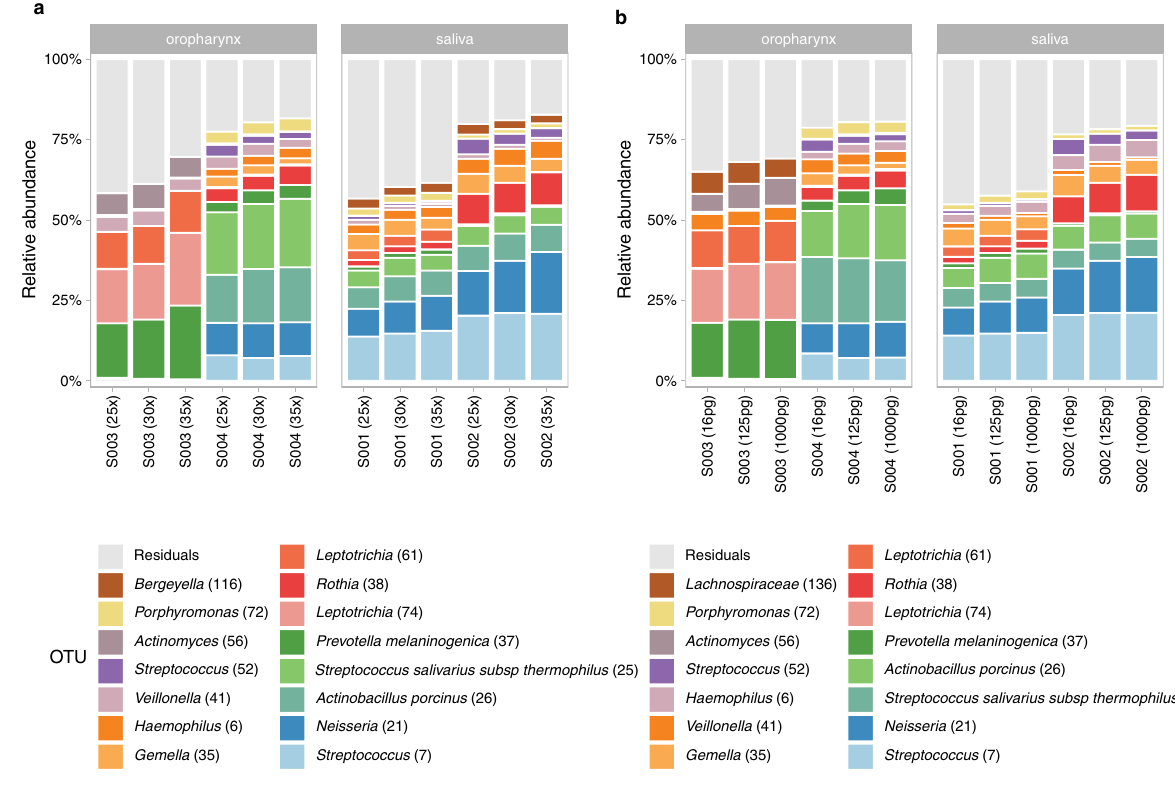
Figure 2. Microbiota composition profiles of 2 oropharynx (S003 and S004) and 2 saliva samples (S001 and S002). Stacked bar charts of the relative abundance of the top 15 OTUs and the residuals are shown. ( a ) Microbiota profile of OP and saliva samples amplified by 25, 30 or 35 PCR cycles. ( b ) Microbiota composition of OP and saliva samples with a bacterial load of 16, 125 or 1000